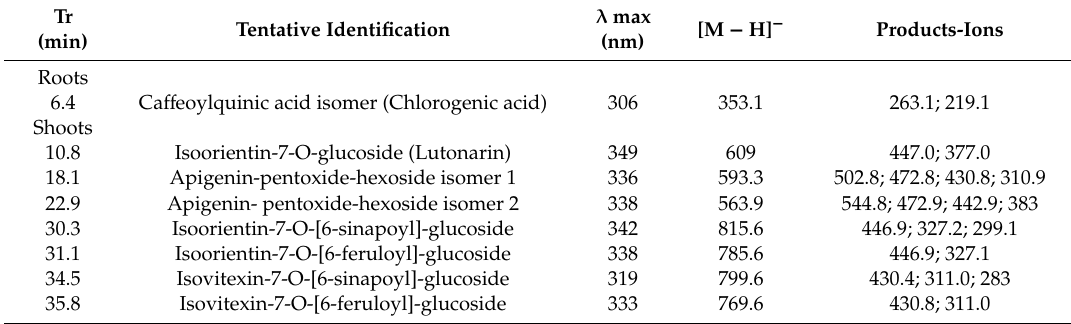
Table 3. Identification of phenolics from barley extracts by using HPLC–DAD–ESI-MS /